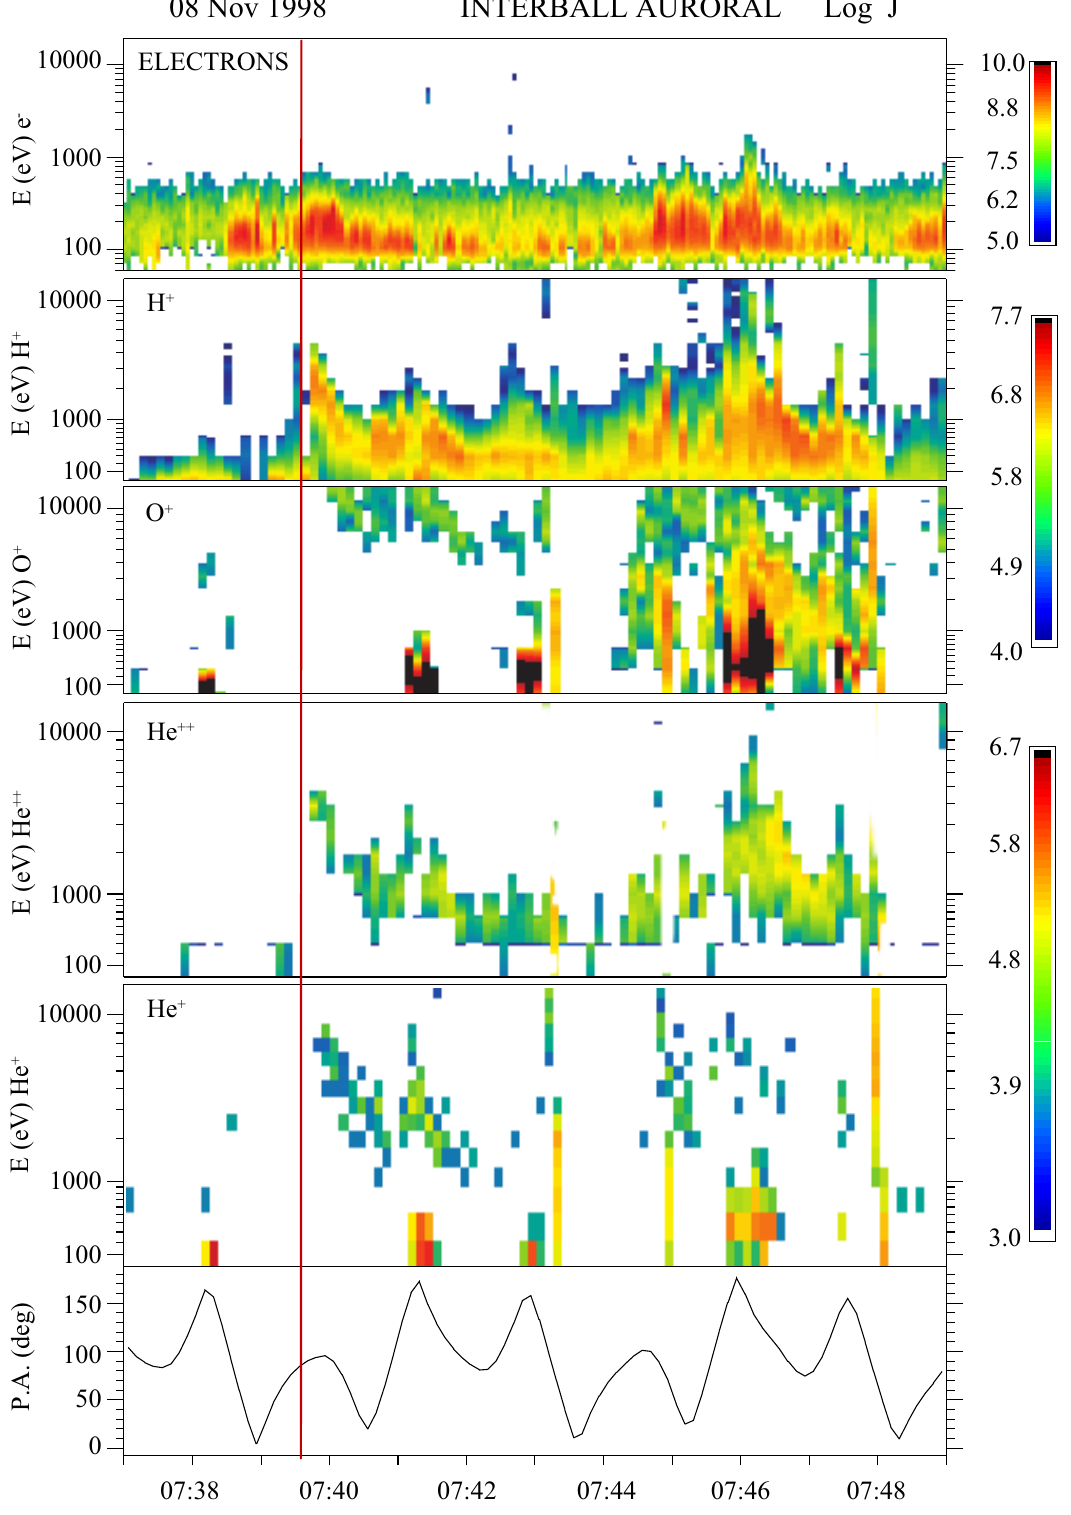
Fig. 3. An enlarged view of Interball Auroral data on 8 November 1998 between 07:37 and 07:49 UT. The red vertical line shows the beginning of an ion dispersed